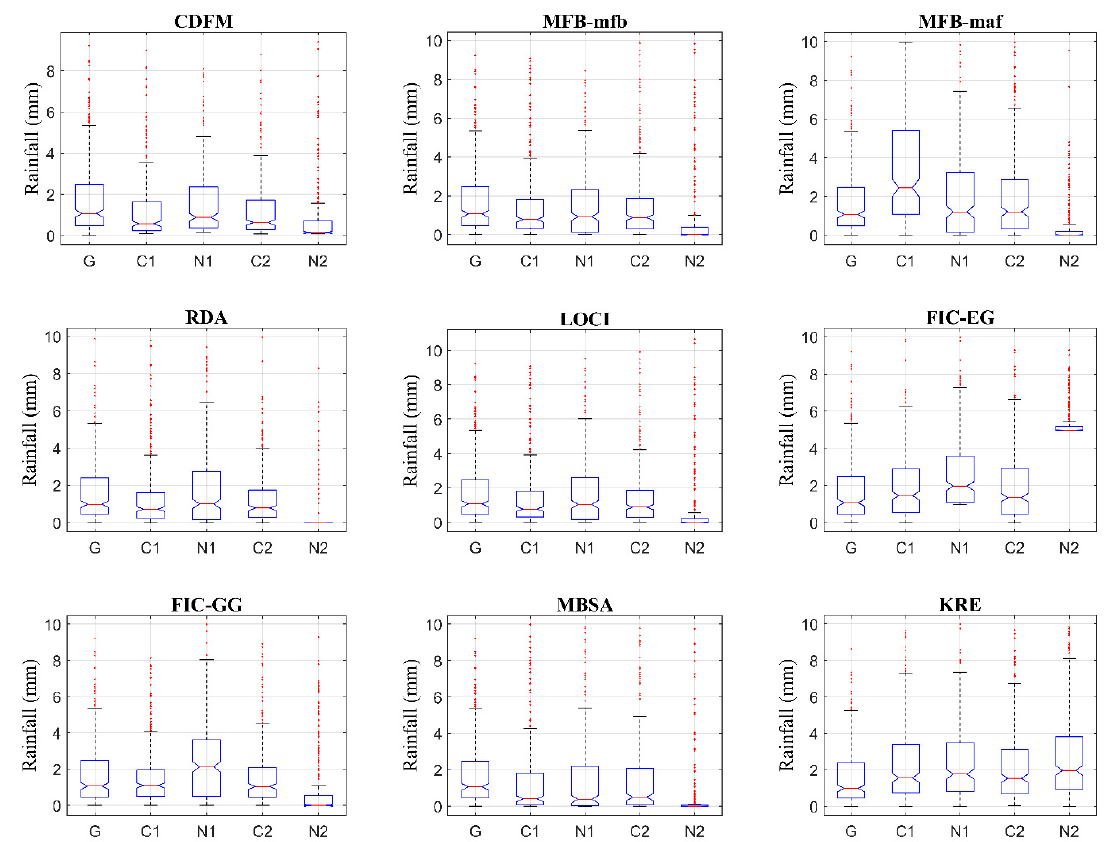
Figure 4. Box plots showing the distribution of precipitation values after radar-gauge merging for Gauge (G), C1, N1, C2, and